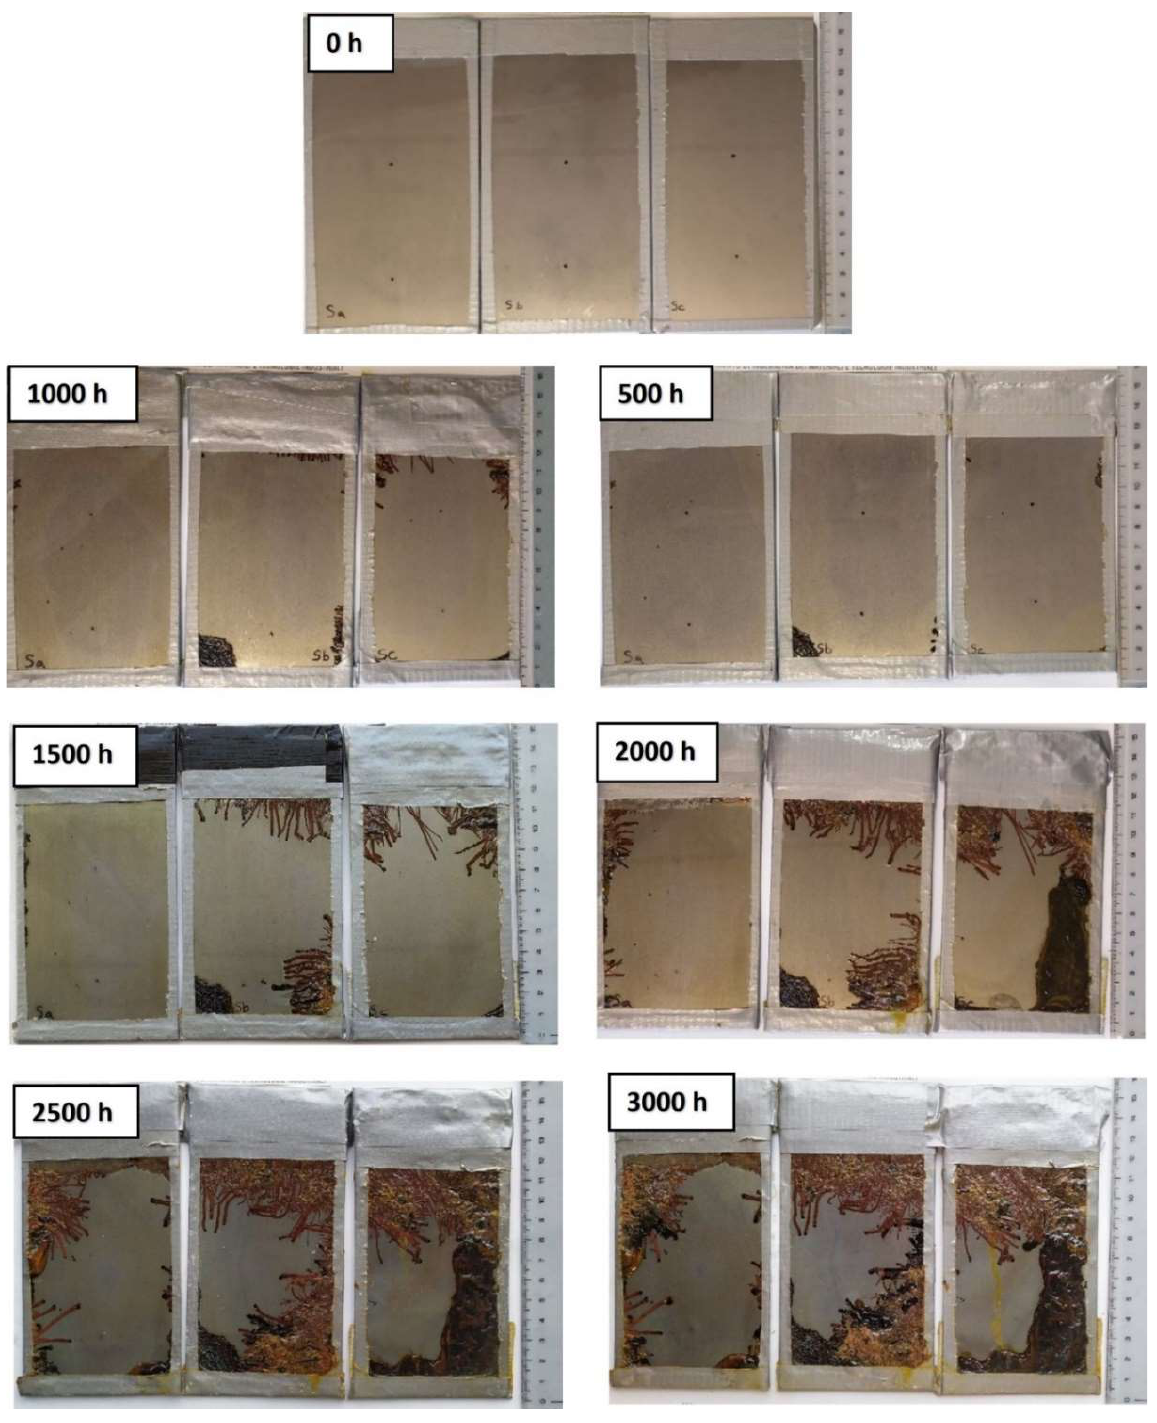
Figure 9. State of damage of painted steel samples after 0, 500, 1000, 1500, 2000, 2500, and 3000 h of the prohesion test.